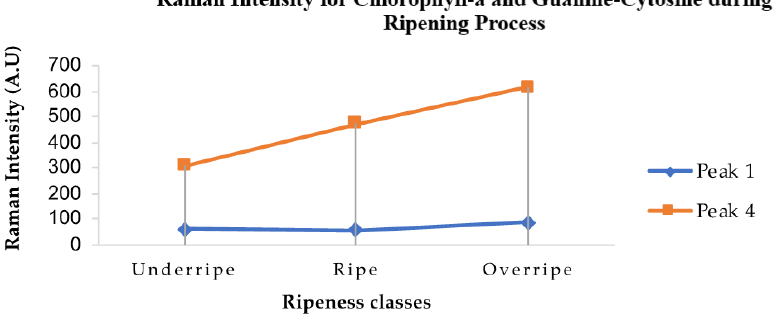
Figure 6. Trend sample B for Raman peak intensity value of chlorophyll-a and guanine-cytosine in fresh oil palm fruit throughout ripening process.